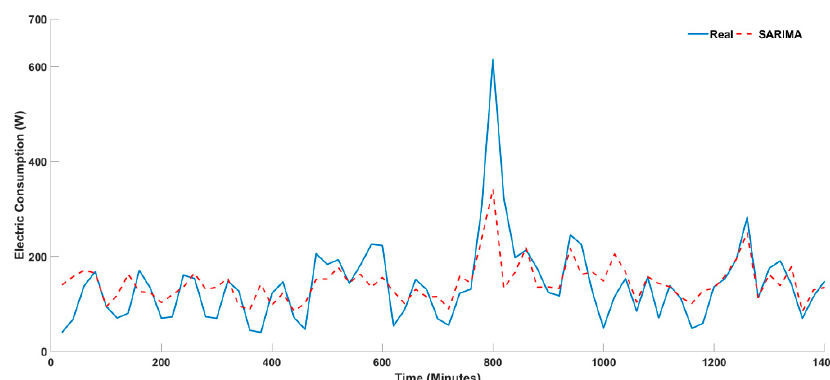
Figure 5. SARIMA for univariate time series.